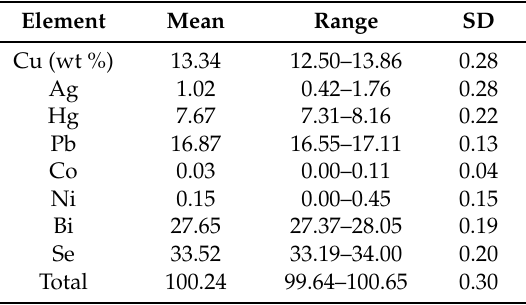
Table 2. Chemical data for quijarroite.